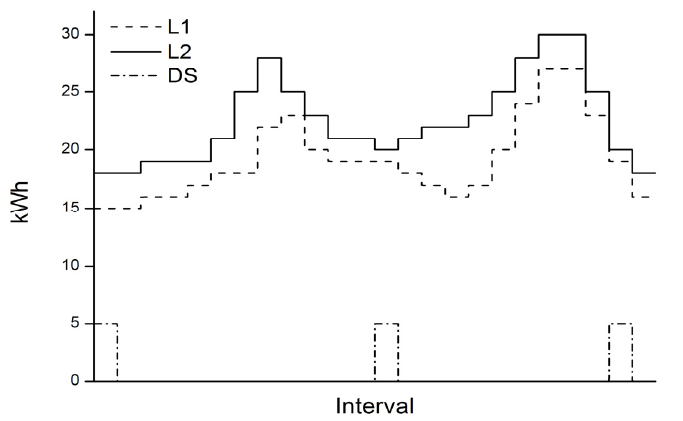
Figure 7. Demand operated by the